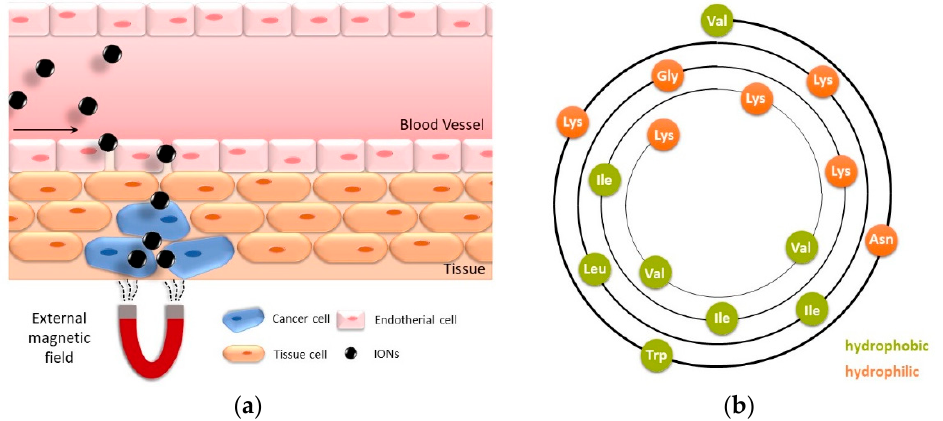
Figure 1. ( a ) Drug delivery of magnetic IONs accumulating in a target tissue, guided by an external magnetic field. ( b ) Wheel diagram of lasioglossin III: hydrophilic amino acids are shown in orange, and hydrophobic amino acids are shown in green.